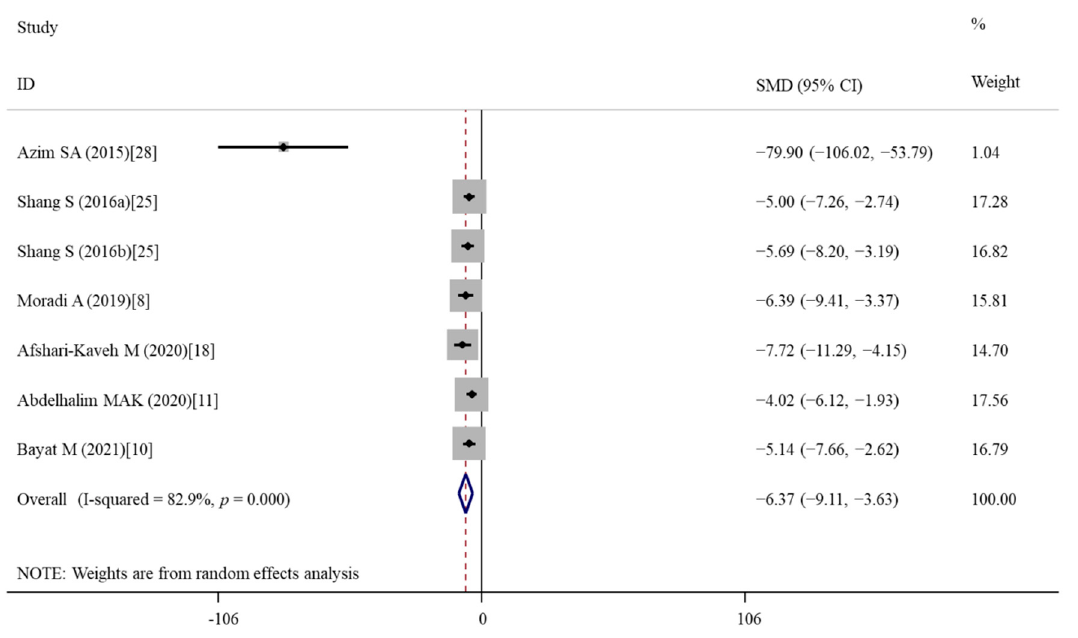
Figure 5. Forest plots showing the protective effects of vitamin E on MDA levels of murine models compared with the nanomaterial exposure group. a, b of the study of Shang et al. represent treat- ment with 0.4 and 4 mg/kg of graphene oxide. MDA, malonaldehyde; SMD, standardized mean difference; CI, confidence interval.